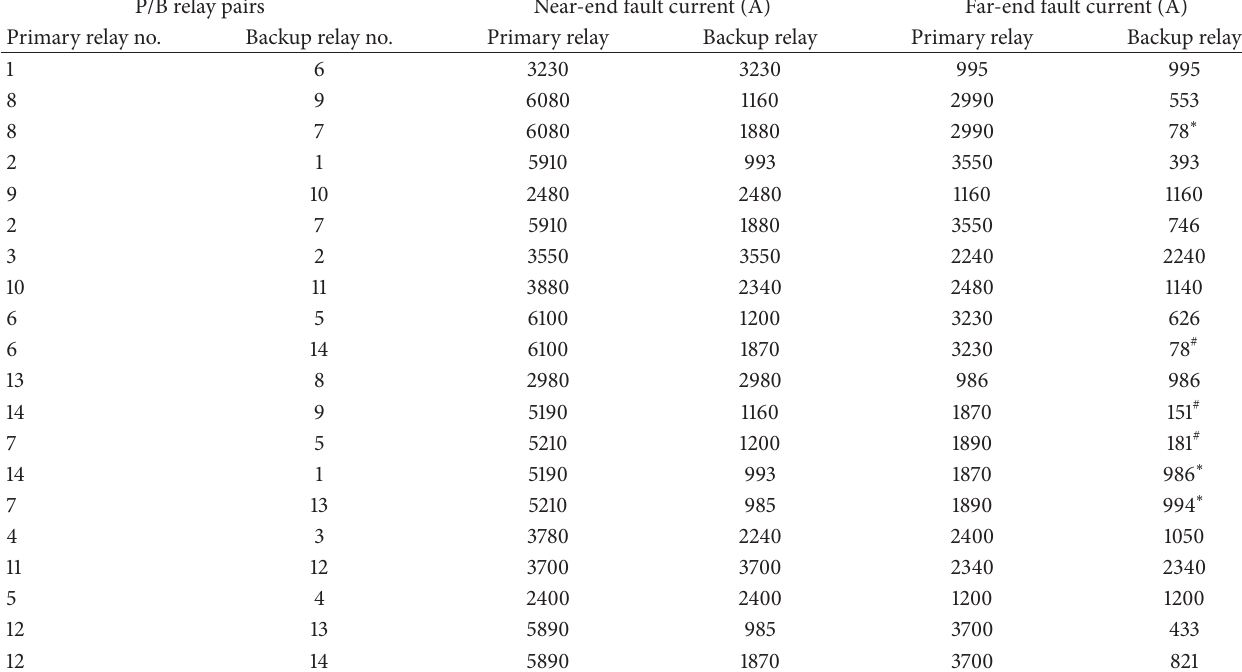
∗ Passing through DOCRs fault current flow reverse direction. # Passing through DOCRs fault current fall below their pickup current.